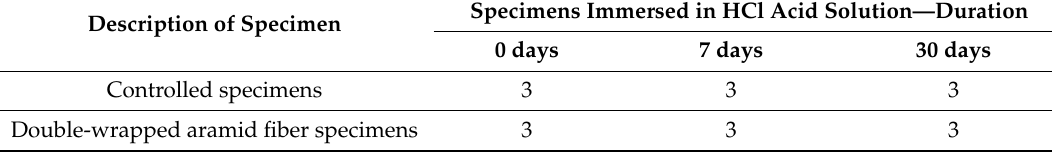
Table 5. Casting of cubes in 2% diluted HCl